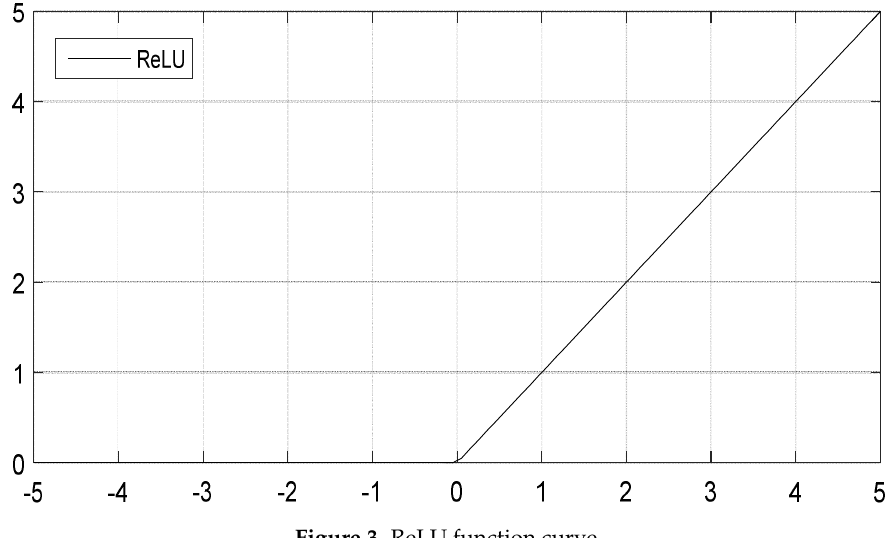
Figure 3. ReLU function curve.